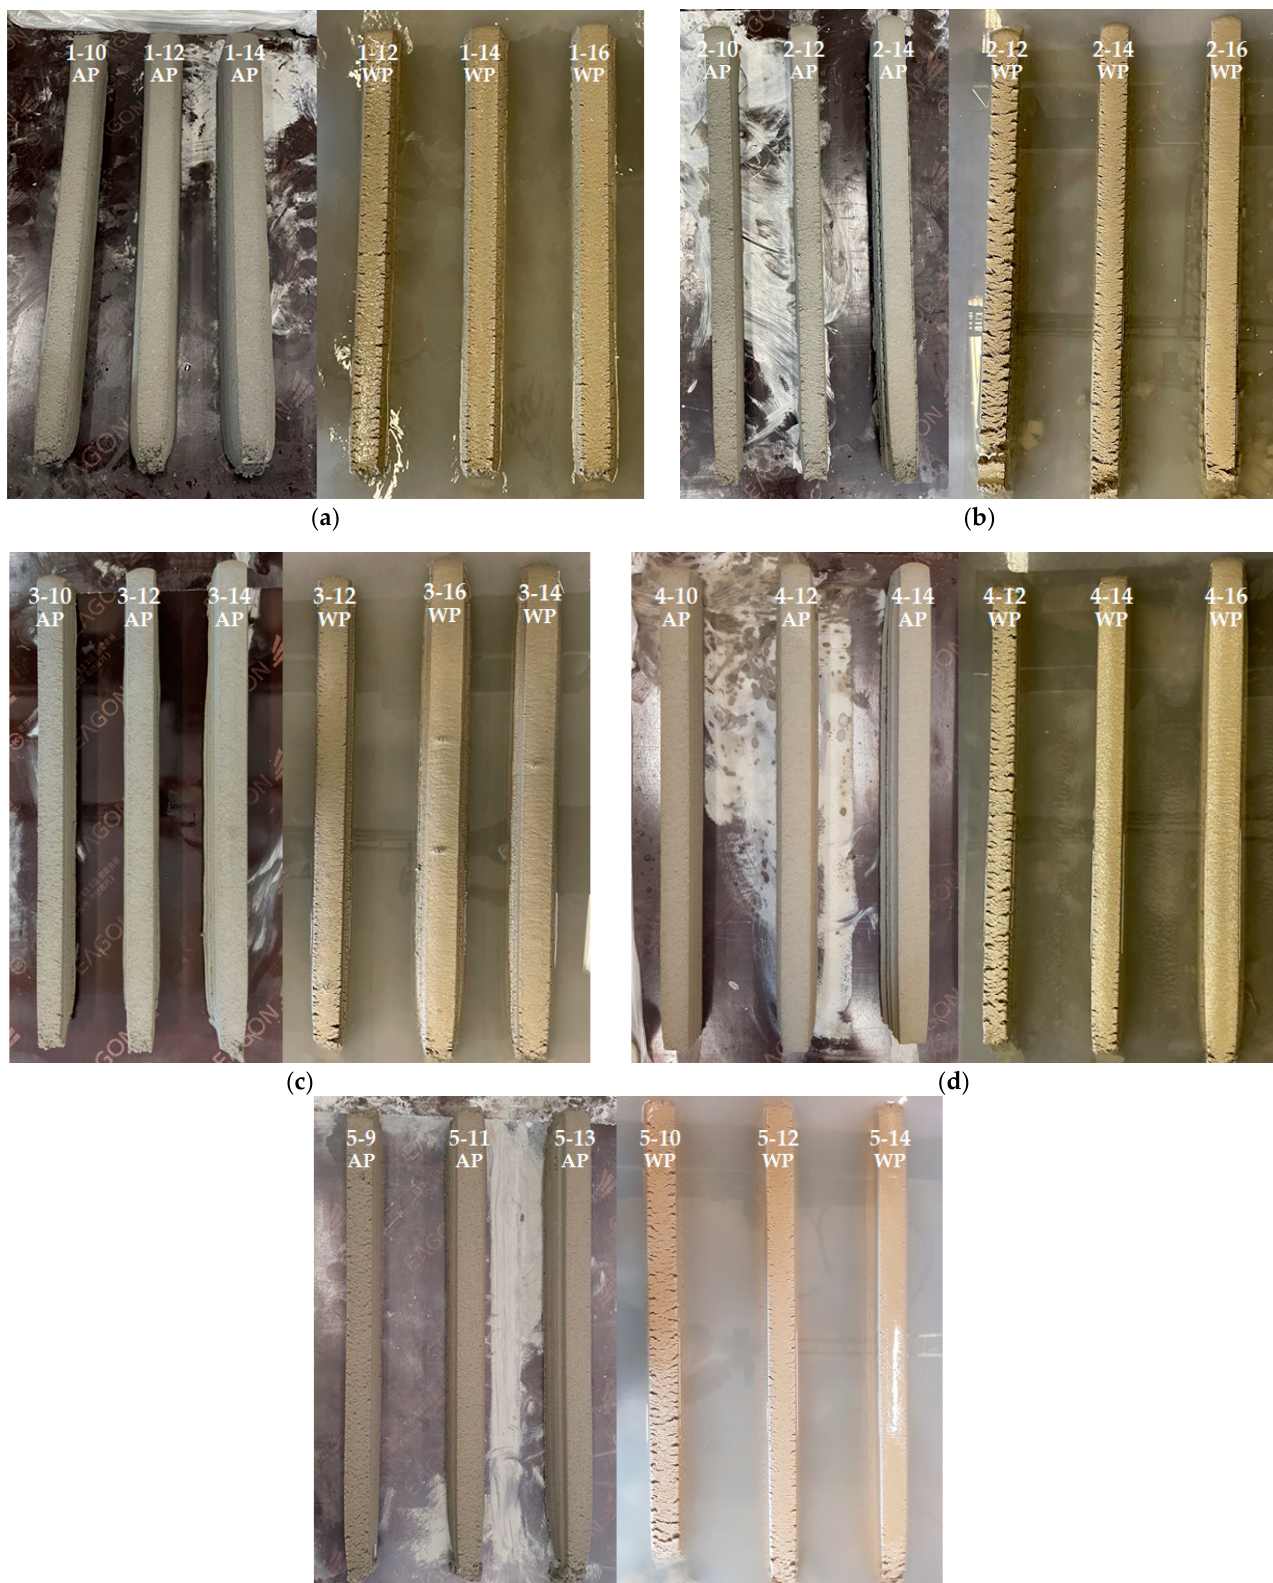
Figure 13. Results of straight-line printing: ( a ) Nozzle#1; ( b ) Nozzle#2; ( c ) Nozzle#3; ( d ) Nozzle#4; ( e ) Nozzle#5. Table 4. Evaluation of printing quality.